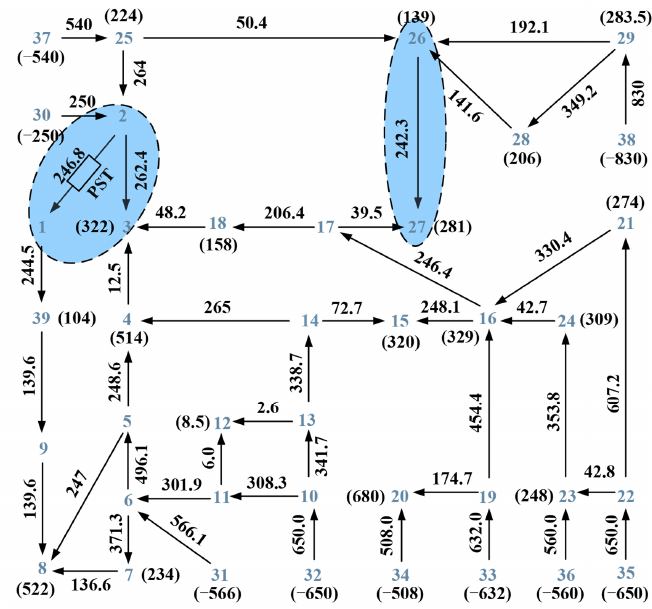
Figure 9. Power flow distribution after installing